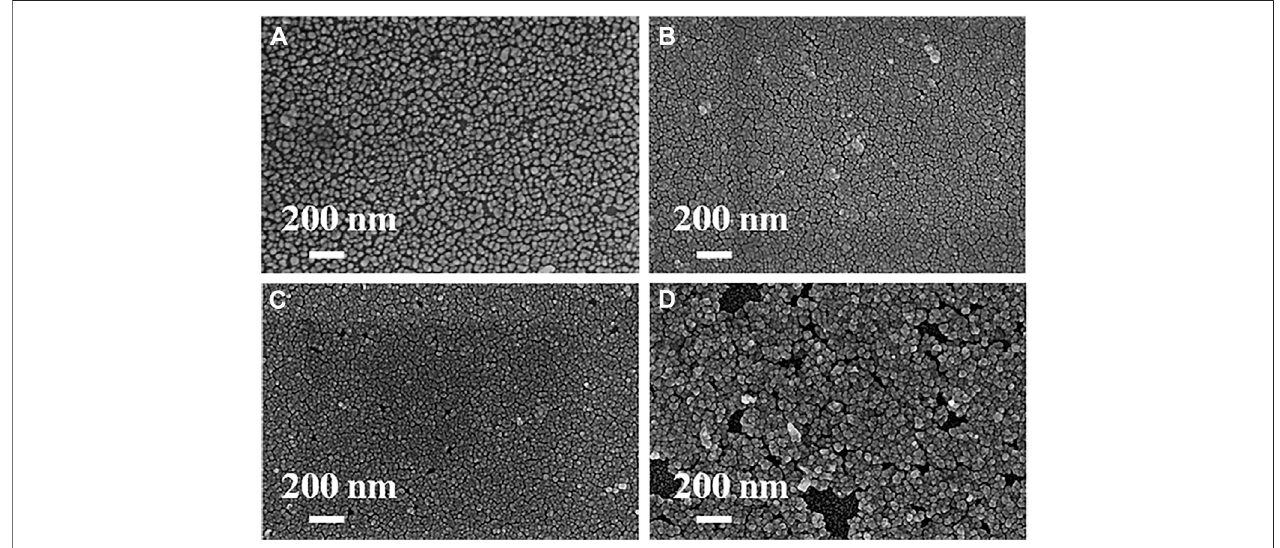
FIGURE 1 | SEM images of the 2D gold nanoclusters on glass slips obtained by merely adjusting the number of growth cycles to (A) 3 cycles (B) 5 cycles (C) 7 cycles and (D) 9 cycles.